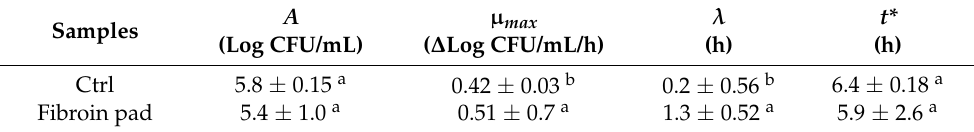
Table 1. Values of parameters calculated by fitting the experimental data.